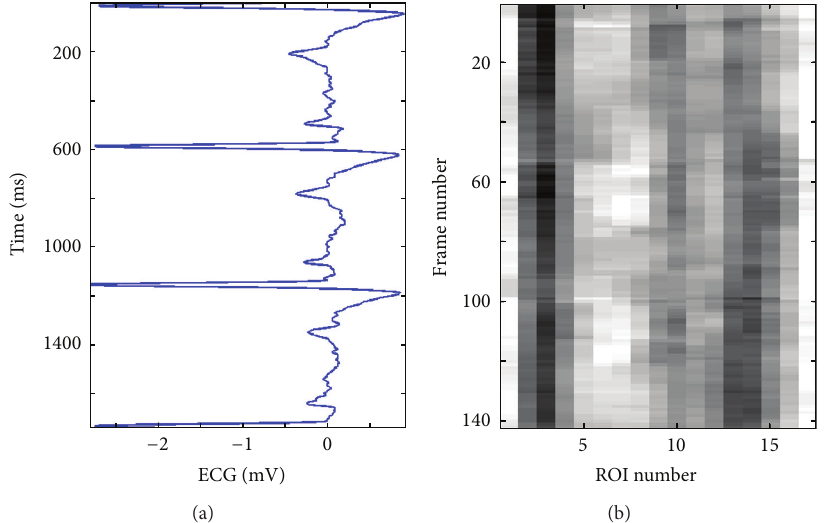
Figure 11: Spatiotemporal wave representation for the pathological case CAD2 (coronary case 2) in Figure 10. The ECG signal is shown to the left (a) and the spatiotemporal 2D map is shown to the right